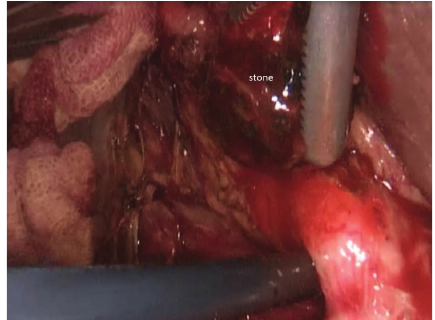
Figure 2: Extracted stone is